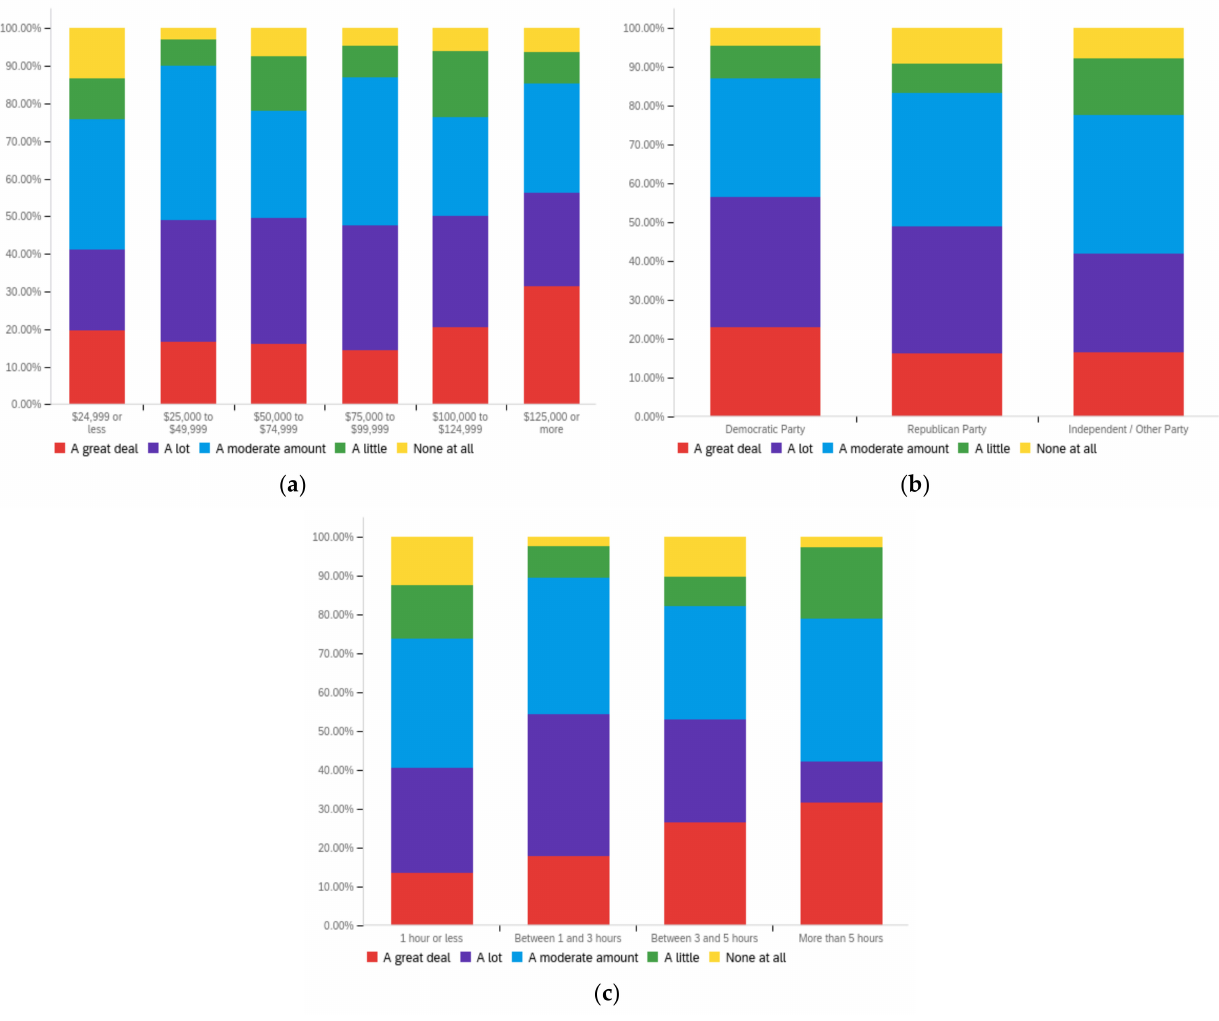
Figure A11. Article author—others’ perception impact by: ( a ) income level (top left), ( b ) political affiliation (top right) and ( c ) online usage